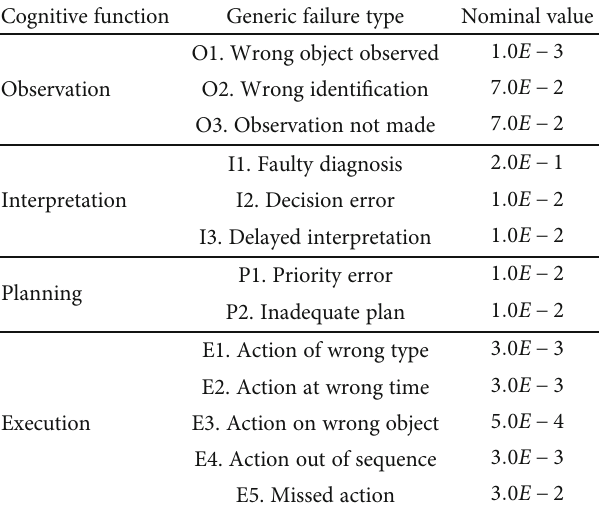
Table 4: Nominal cognitive error probability.